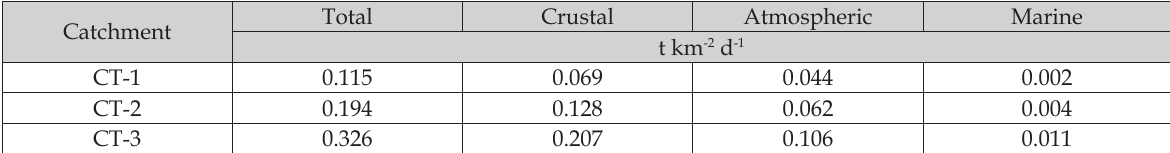
Table 4. load of dissolved matter discharged from the river catchments in the area of Kaffiøyra plain